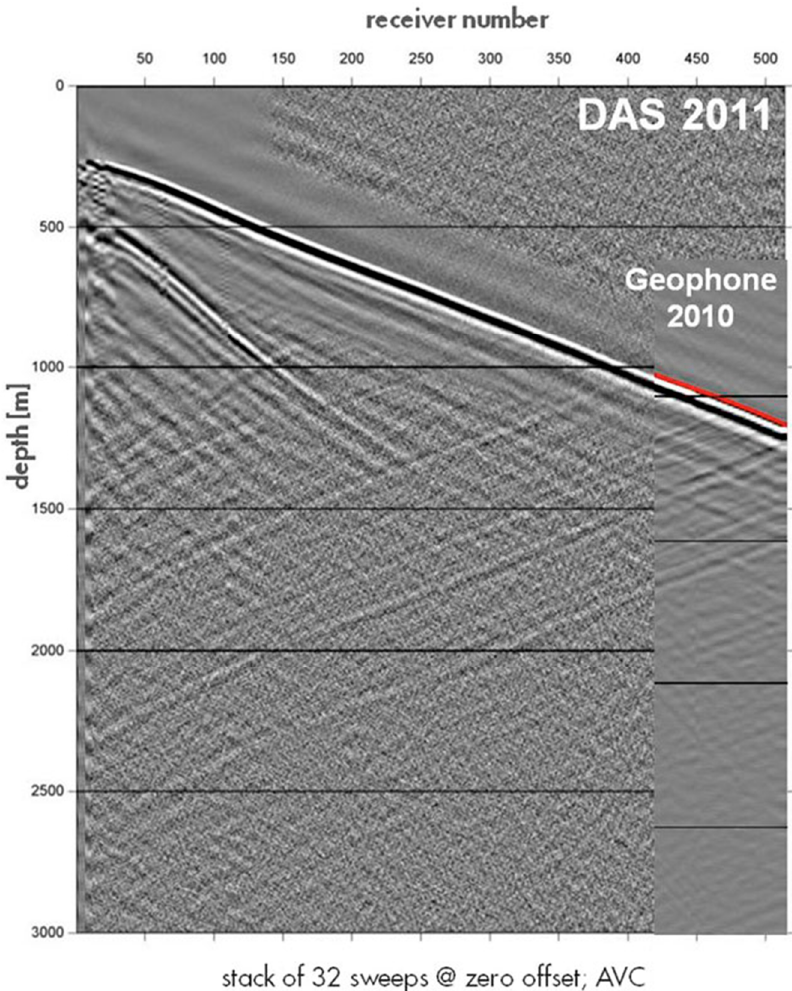
Figure 3. One of the first examples of DAS-VSP records, with data acquired at Pinedale in 2011. Despite a large number of stacked sources, DAS data are noisy. However, downgoing and upgoing P-wave energy is visible, demonstrating the potential of DAS for VSP studies. For shallow DAS locations, the direct S-wave is also visible. DAS measurements are in good agreement, kinematically, with downhole geophones deployed in the same well. Figure from Mateeva et al. (2013), The Leading Edge.